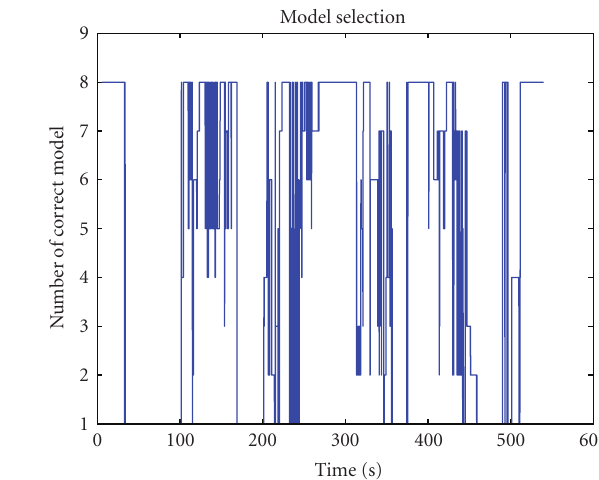
Figure 15: Number of correct model in IMM L structure.